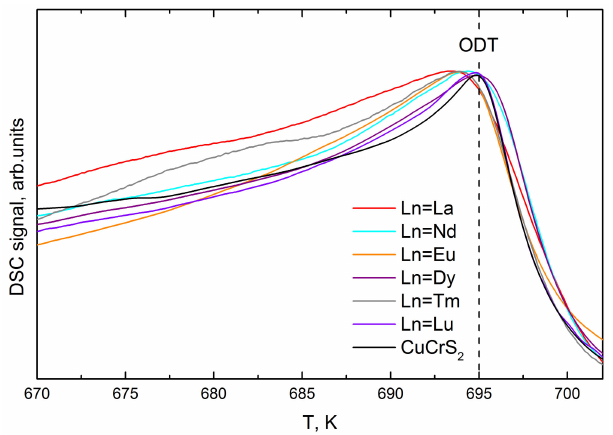
Figure 5. DSC-signal of initial CuCrS 2 -matrix and CuCr 0.99 Ln 0.01 S 2 (Ln = La, Nd, Eu, Dy, Tm, Lu) solid solutions in the temperature region of the